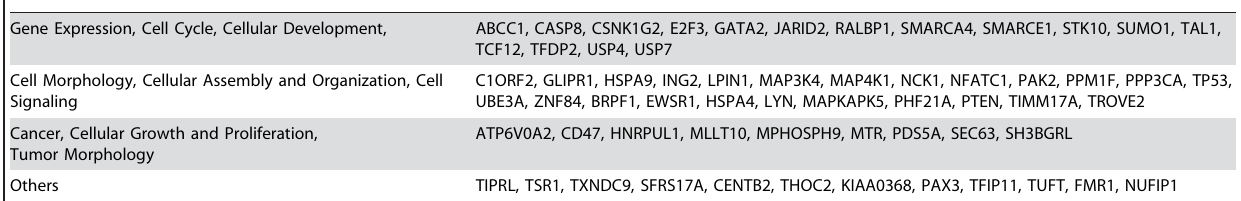
Major functions Well-annotated genes